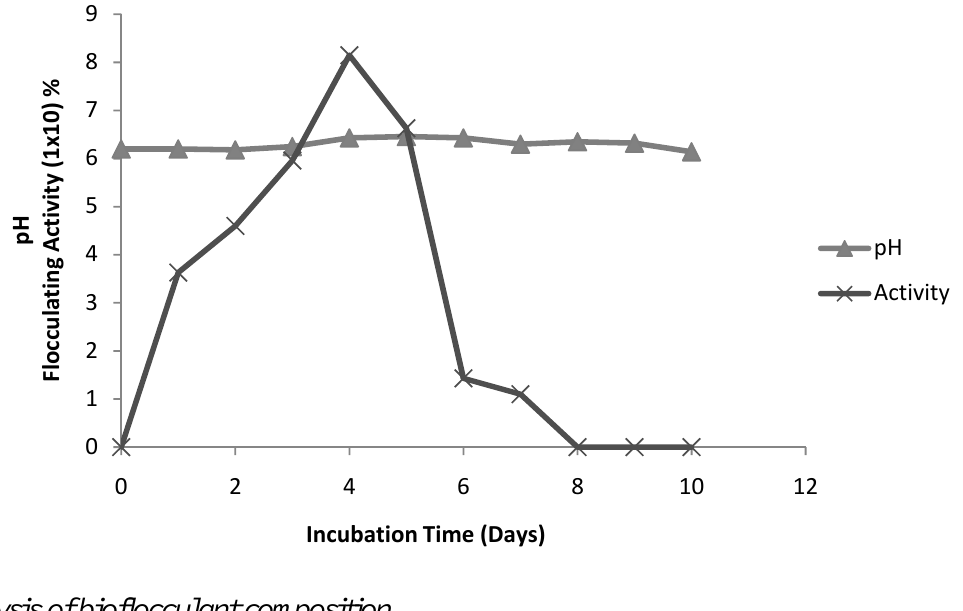
Figure 3. Time course of bioflocculant production Virgibaccilus sp.